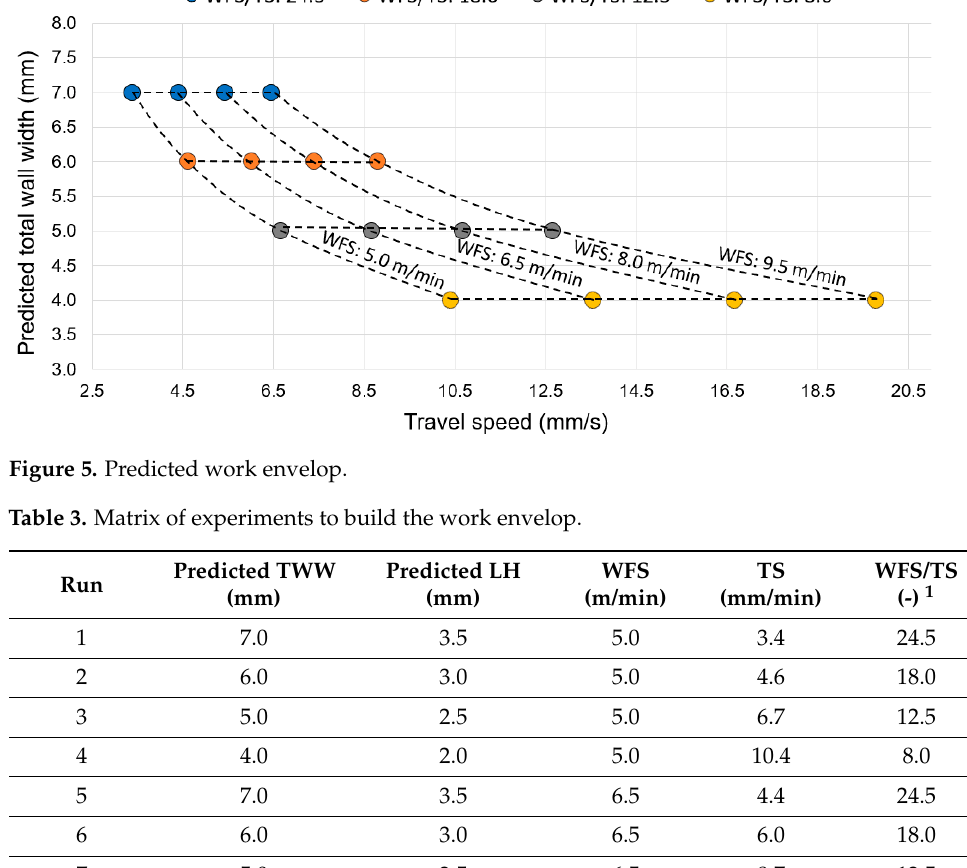
Table 3. Matrix of experiments to build the work envelop.